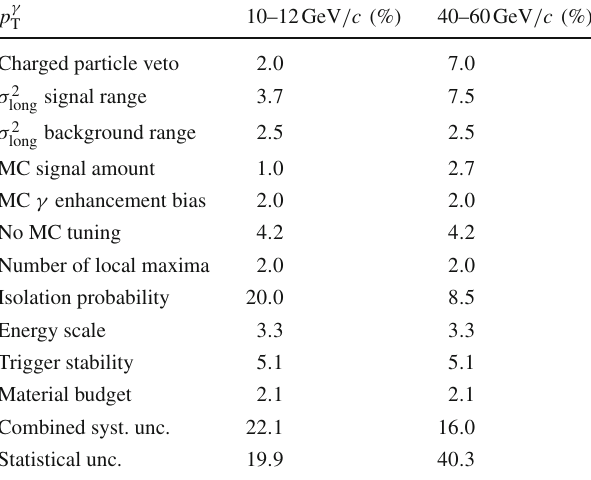
the corresponding σ 2 interval to smaller and larger long